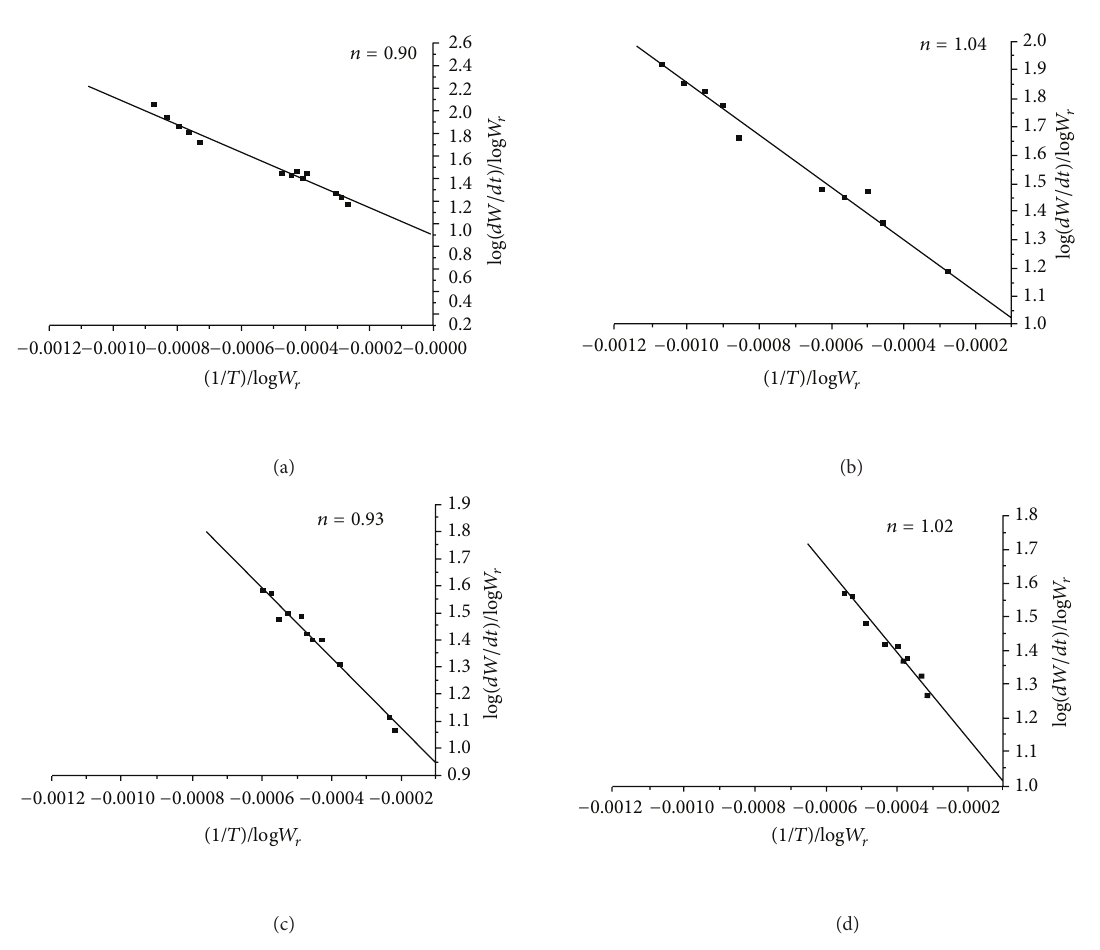
Figure 11: Freeman-Carroll plots ( 𝑛 ) of (a) BEF ligand, (b) BEF–Cu, (c) BEF–Ni, and (d)